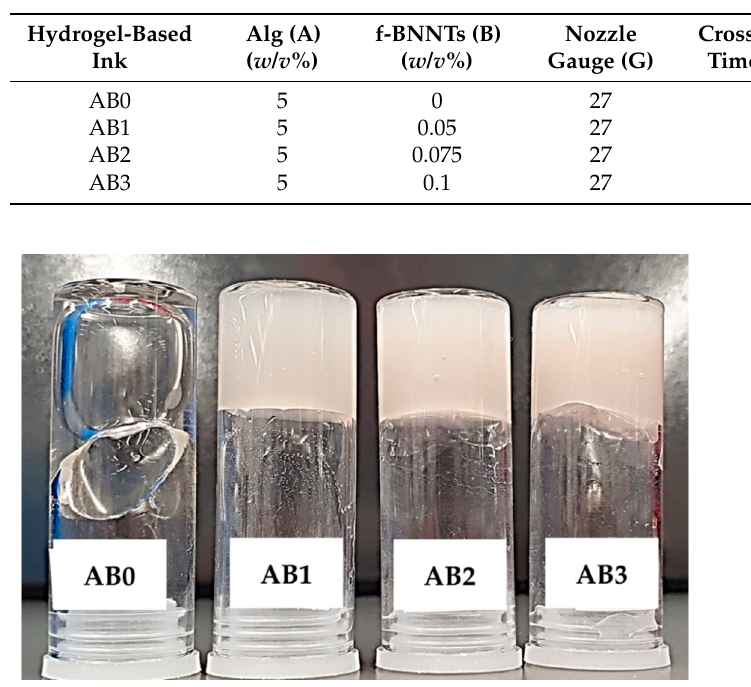
Figure 3. Developed hydrogel-based Alg and Alg with f-BNNTs ink for 3D